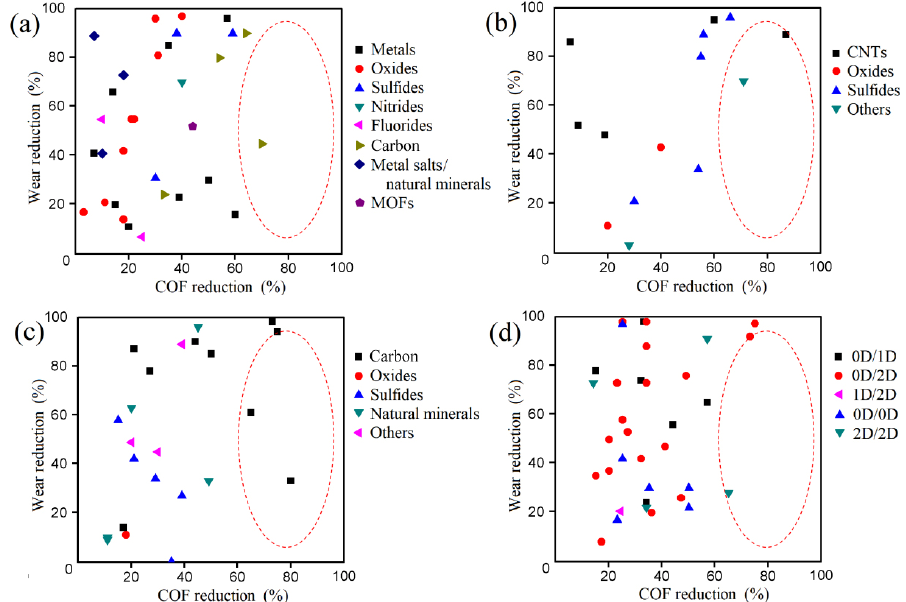
Fig. 12 Statistical analysis of friction reduction and anti-wear properties of four types of nanomaterials with different nanostructured features: (a) 0D nanomaterials; (b) 1D nanomaterials; (c) 2D nanomaterials; and (d)